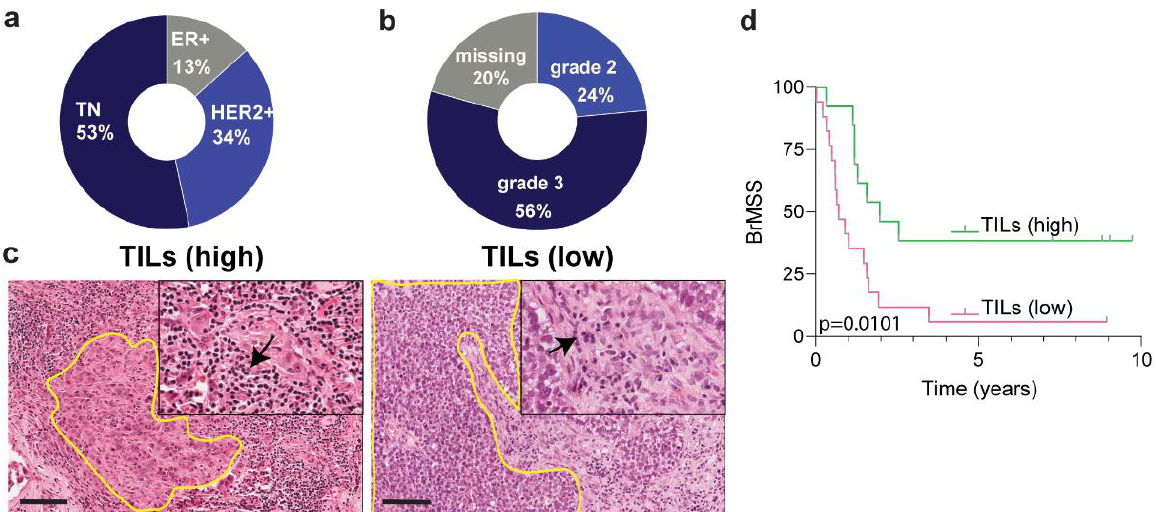
Figure 1. Cohort demographics and survival analyses. ( a ) Subtype breakdown of the primary breast cancers giving rise to the brain metastases; ( b ) tumor grade breakdown of the cohort; ( c ) hematoxylin and eosin stained representative image for TILs scoring and grouping; ( d ) Kaplan – Meier curve analysis showing brain metastasis specific survival of the high TILs and low TILs groups; TILs are indicated by arrows and yellow demarcated lines show the tumor. Scale bar 100 µm.